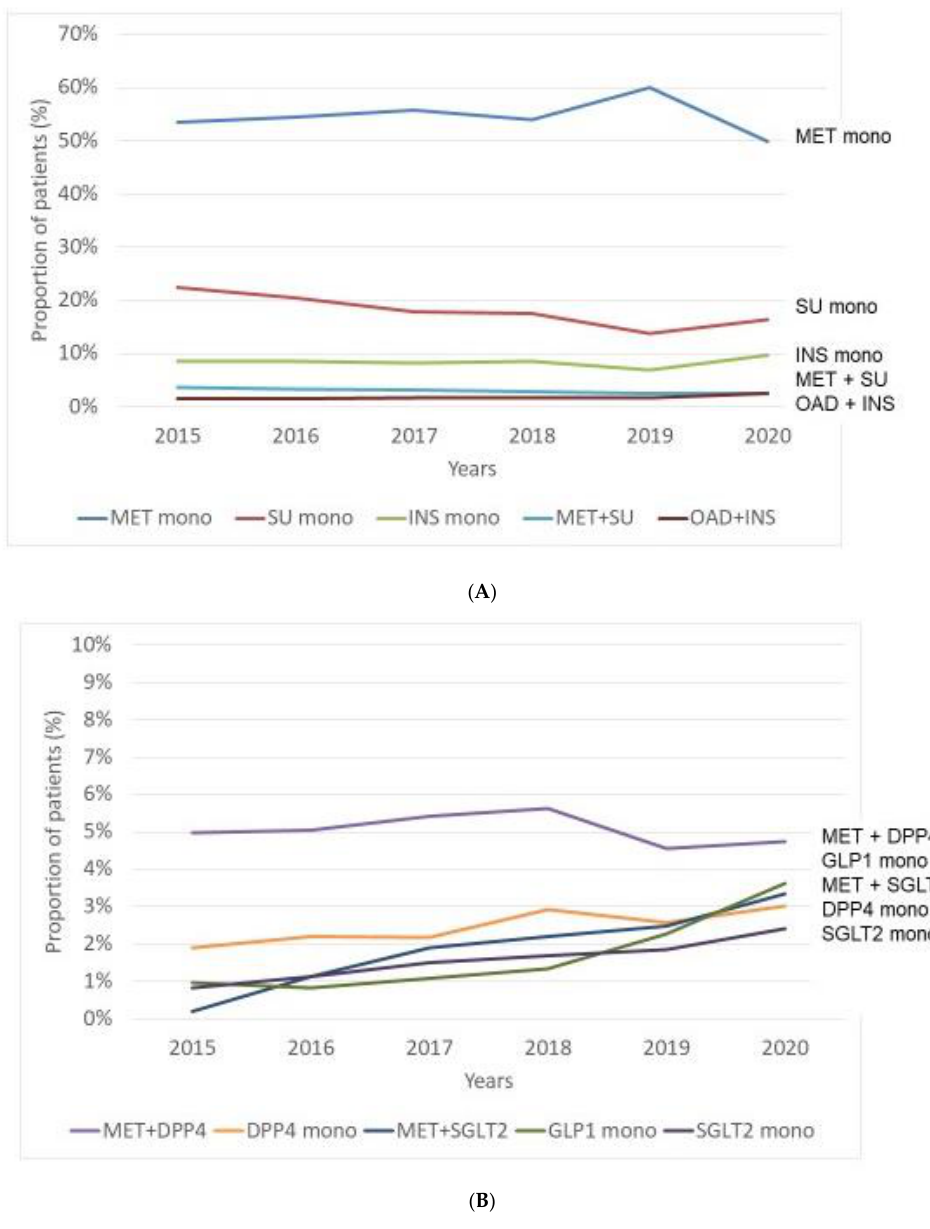
Figure 3. Treatment patterns of patients with type 2 diabetes mellitus (T2DM) in the period of 2015–2020, according to the initial pharmacological intervention. Top 10 incidence rates of T2DM-patients treated initially with traditional antihyperglycaemic agents ( A ) or with novel drugs ( B ). MET: metformin, INS: insulin, SU: sulfonylurea, OAD: oral antidiabetic drug, DPP4: dipeptidyl peptidase-4